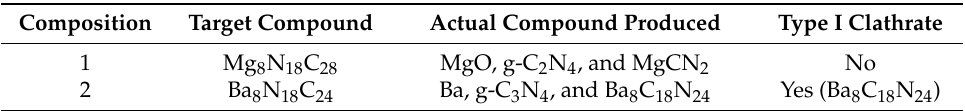
Table 5. Summary of targeted compounds and actual compounds produced by arc-melting From Chan et al.